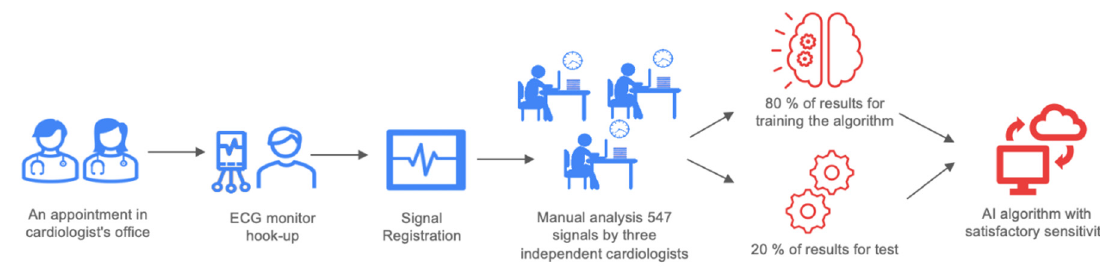
Figure 1. Project workflow.